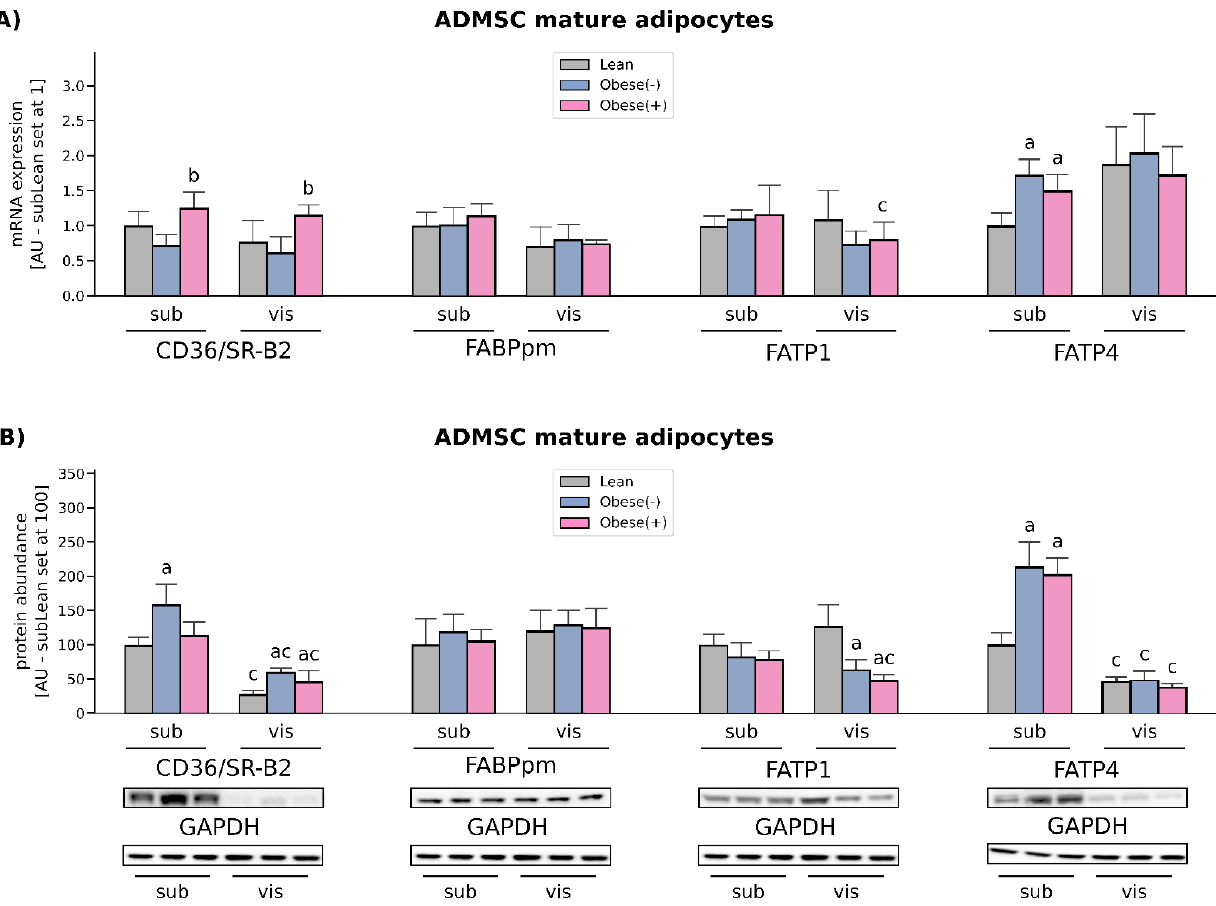
Figure 3. Quantification of ( A ) mRNA and ( B ) protein abundance of CD36/SR-B2, FABPpm, FATP1 and FATP4 in fully differentiated adipocytes derived from subADMSCs and visADMSCs of lean and morbidly obese women. Values are expressed in arbitrary units; the mean in adipocytes differentiated from the subADMSCs’ lean control was set at 1 or 100, respectively. Representative Western Blot images are shown. a–difference vs. Lean group in the studied tissue; b–difference vs. Obese(-) group in the studied tissue; c–difference between adipocytes differentiated from visADMSCs vs. subADMSCs within the patient metabolic status. Data are presented as mean ± SD ( n = 4 for each study group, measurements taken in duplicate for rtPCR method and n = 3 for WB analysis). p < 0.05. Designation of the groups: Obese(-)–obese without metabolic syndrome patients; Obese(+)–obese with metabolic syndrome